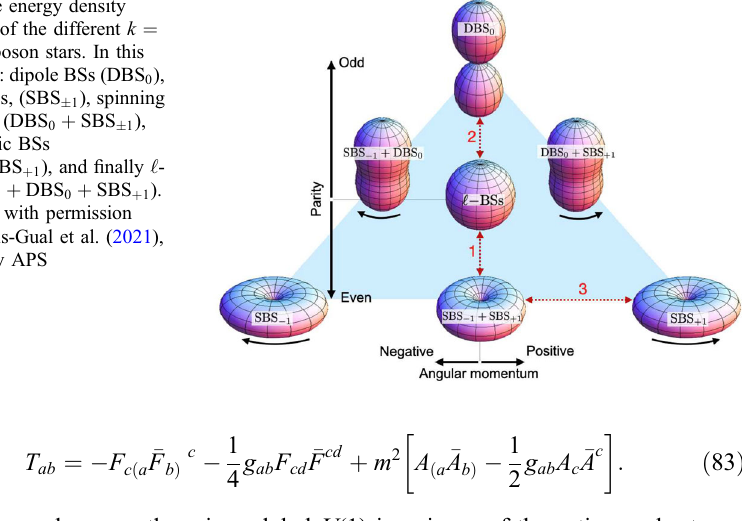
Fig. 12 The energy density distribution of the different k ¼ 1 hybrid- ‘ -boson stars. In this case, we see: dipole BSs (DBS 0 ), spinning BSs, (SBS (cid:10) 1 ), spinning dipolar BSs (DBS 0 þ SBS (cid:10) 1 ), toroidal static BSs (SBS (cid:4) 1 þ SBS þ 1 ), and fi nally ‘ - BSs (SBS (cid:4) 1 þ DBS 0 þ SBS þ 1 ). Reproduced with permission from Sanchis-Gual et al. (2021), copyright by